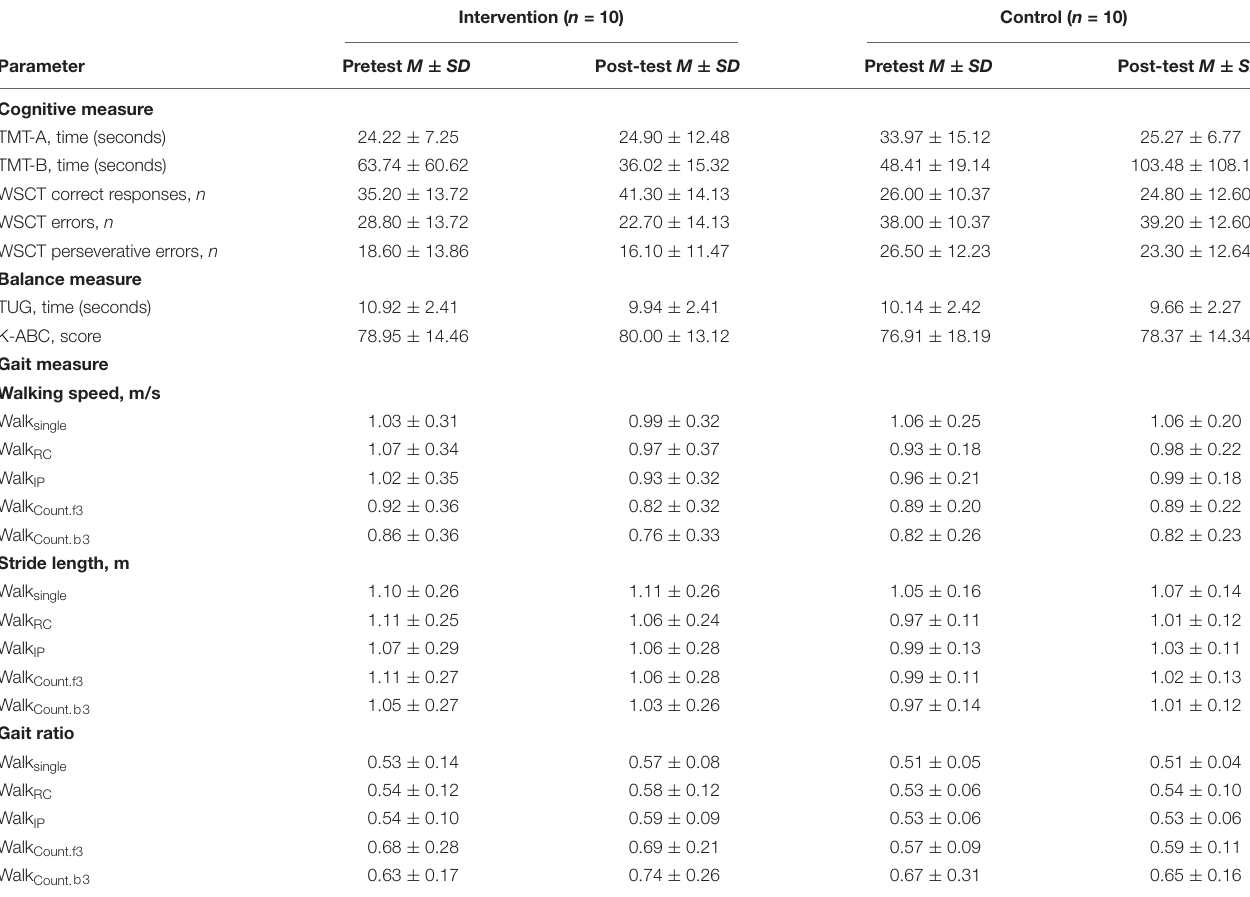
TABLE 3 | Changes in cognitive, balance, and gait measures in each